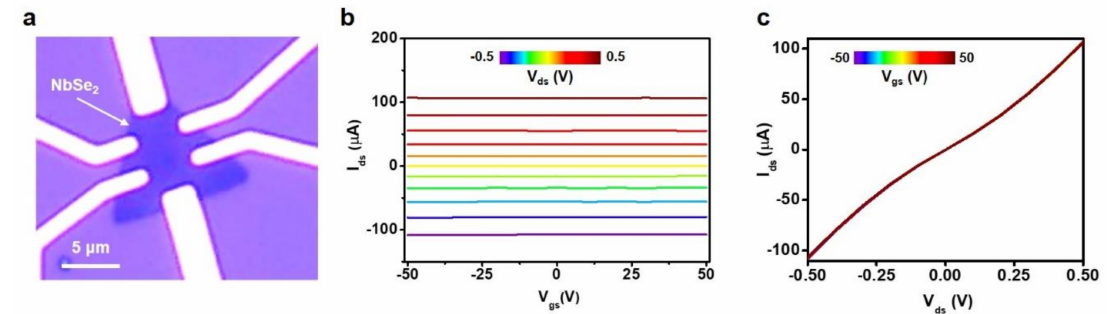
Figure 3. Electrical properties of the CVD-grown NbSe 2 field-e ff ect transistor ( FET) device. ( a ) Optical image of the NbSe 2 device with drain and source electrodes; ( b ) transfer characteristic with gate voltage sweep from − 50 V to 50 V under constant drain bias ranges from − 0.5 V to 0.5 V. No switching property was observed according to the gate voltage. ( c ) Output characteristic with drain voltage sweep from − 0.5 V to 0.5 V under constant gate bias ranges from − 50 V to 50 V. Under di ff erent gate biases, a similar current level of drain bias was observed, which also shows the metallic properties, no gate